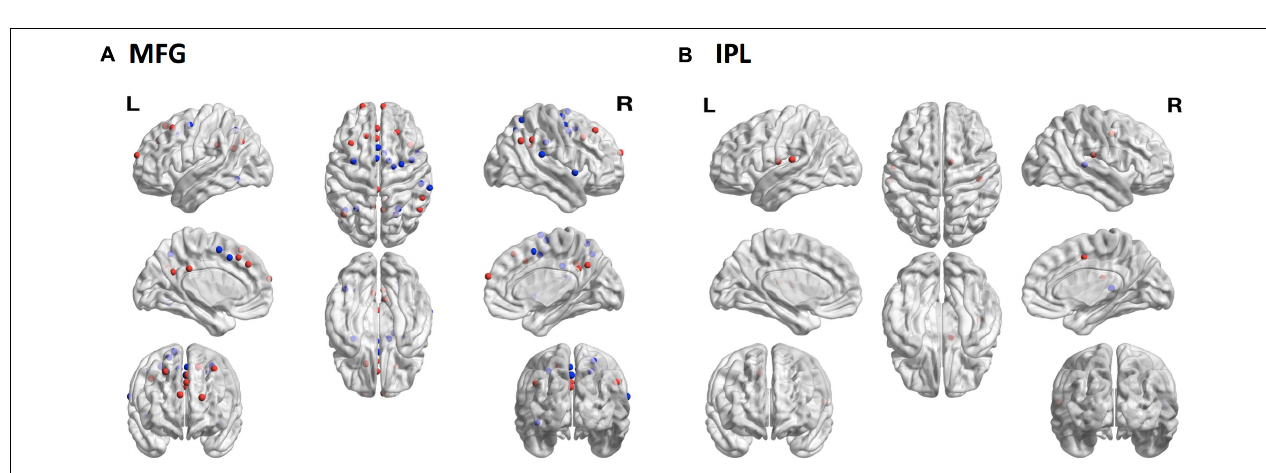
FIGURE 6 | Consequences of sampling variability. The locations of 264 brain regions showing differences in seed-based functional connectivity patterns from the subject-specific samples relative to the reference samples. (A) In MFG there were 15 regions with decreased (blue dots) and 15 regions with increased (red dots) connectivity to the subject-specific sample compared to the reference sample. (B) In IPL one region showed decreased (blue dot) and four regions showed increased (red dots) connectivity to the subject-specific sample compared to the reference sample. MFG, middle frontal gyrus; IPL, inferior parietal